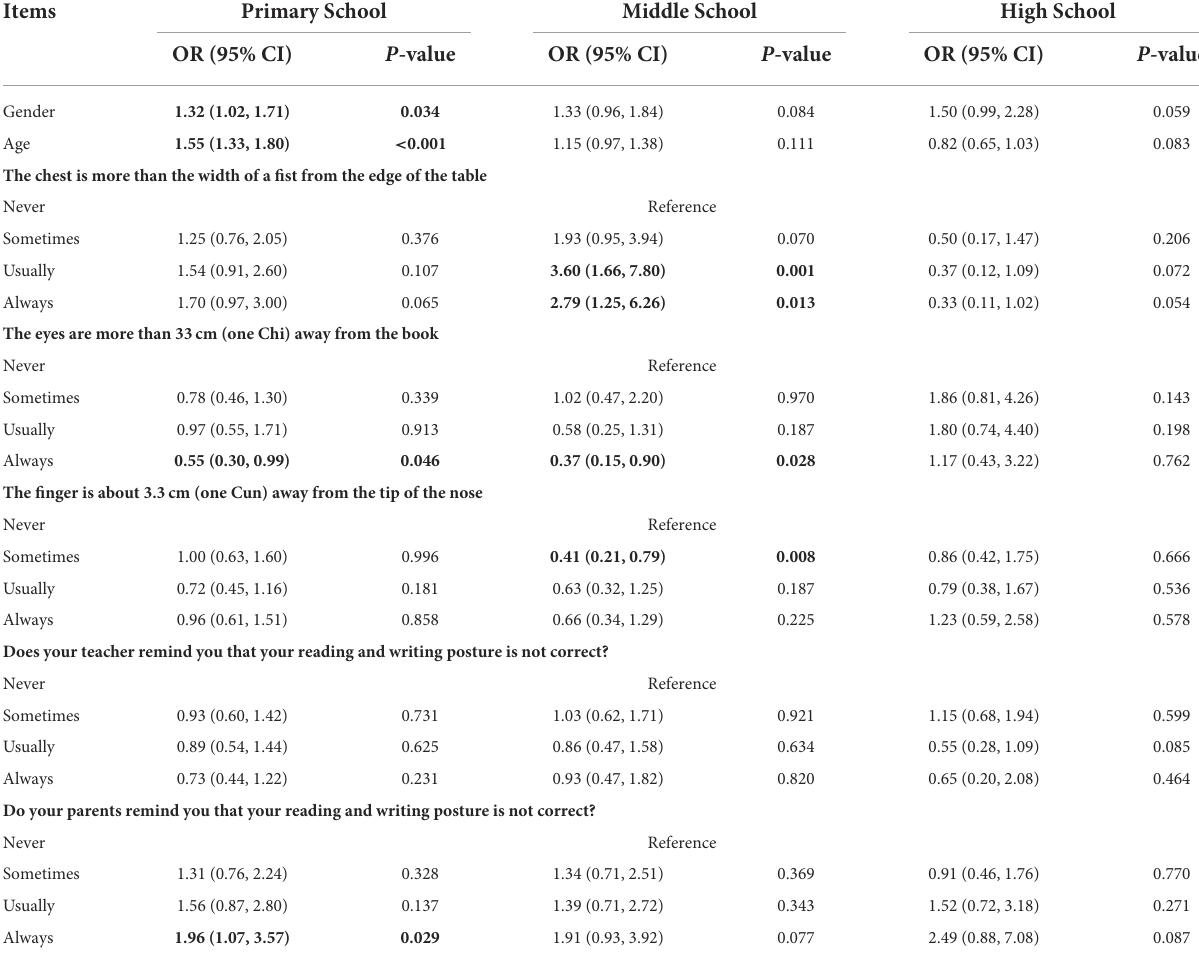
TABLE 3 Logistic regression of myopia-related factors by school